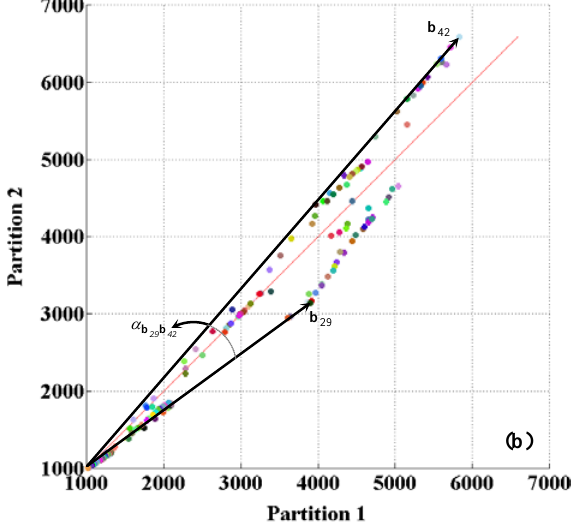
Figure 2. Partition space construction: (a) Image partitioning and spectral space showing the mean spectra of two partitions. (b) Partition space, constructed by the mean spectra of Partition 1 and Partition 2, which represents the bands scatter. The band vectors b 29 and b 42 correspond to the 29th and 42th selected α is the angle between these two vectors in features, and 4229 bb the PS.